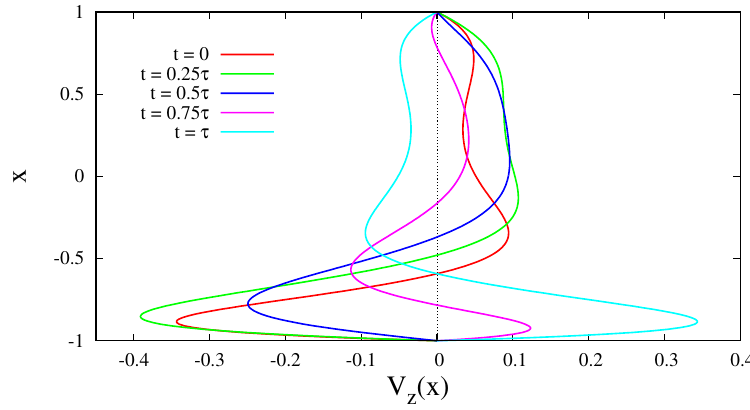
Figure 3. Velocity profile for non-stationary chemovibrational fluid flow induced by the first-order chemical reaction at different moments in time over a half-period of vibrations τ . Parameters are set to D = 10, Sc = 1, Ra = 1000, Ω = 30. The half-period of vibrations is equal to τ = π